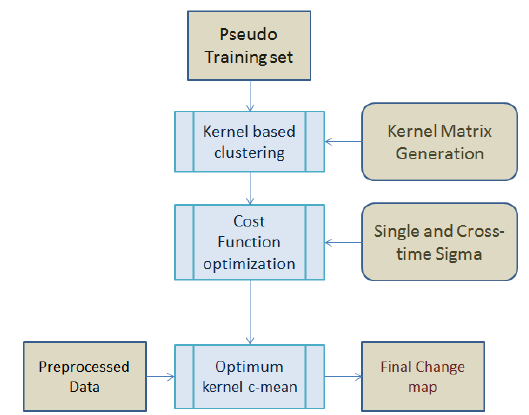
Figure 2. Mixture of two Gaussians histograms for change and no-change area. Figure 3. Overview for the main step of the proposed